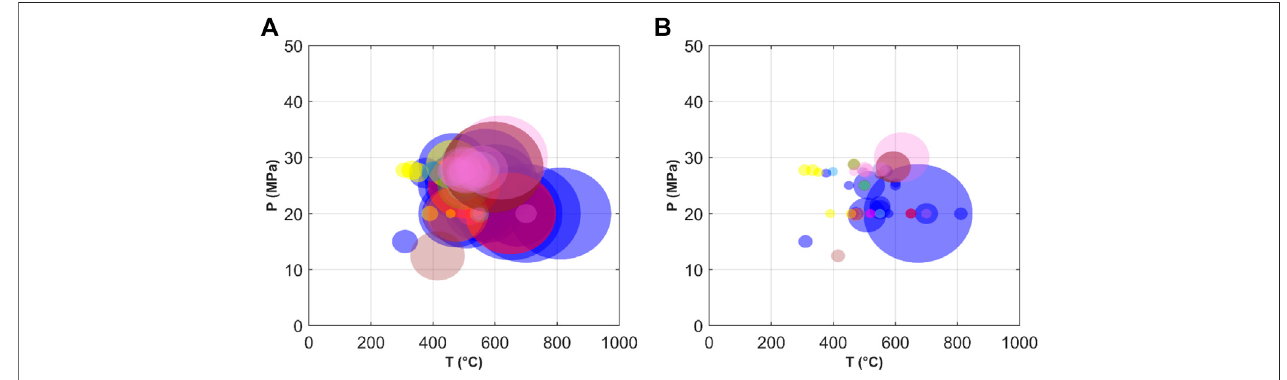
FIGURE5| Boundaryconditionsofsplit- fl owsCO 2 cyclesasafunctionofthemaximumoperationtemperatureandpressure: (A) Thermalef fi ciency; (B) Netpower output (legend: